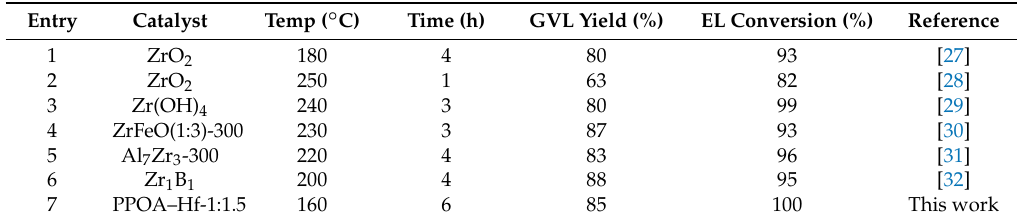
Table 1. Activity contrast of previous studies in the conversion of ethyl levulinate (EL) into γ -valerolactone (GVL).